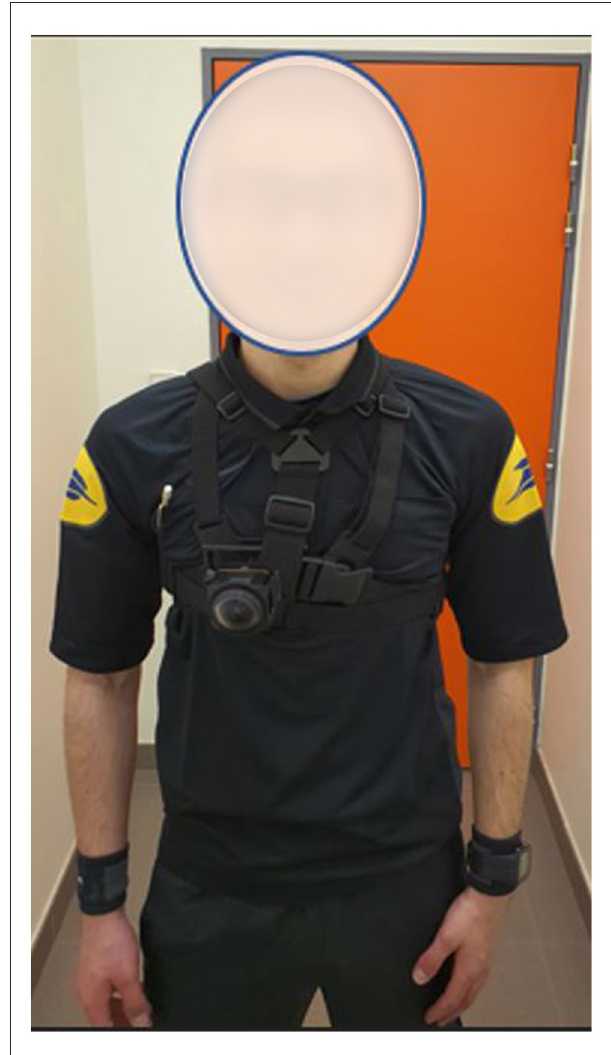
FIGURE1 Front view of the waistcoat and the support used to fix the